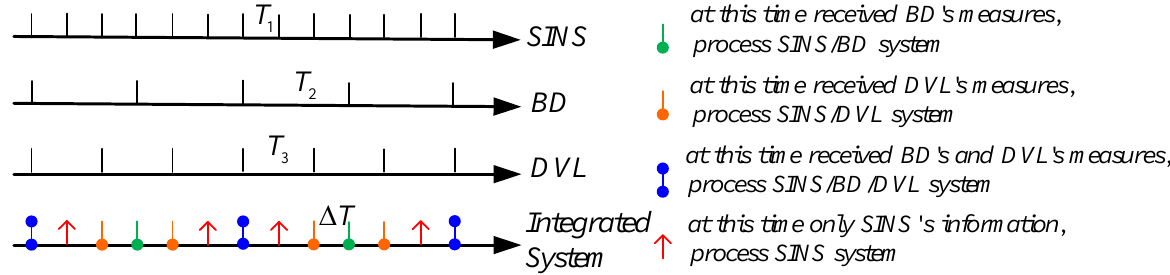
Figure 2. The sampling principle of SINS/BD/DVL integrated navigation